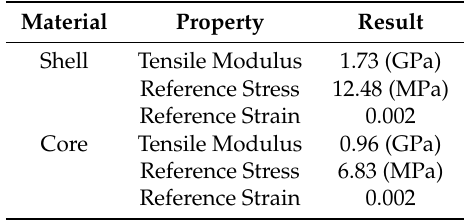
Table 4. Material inputs for the non-linear FEA model.